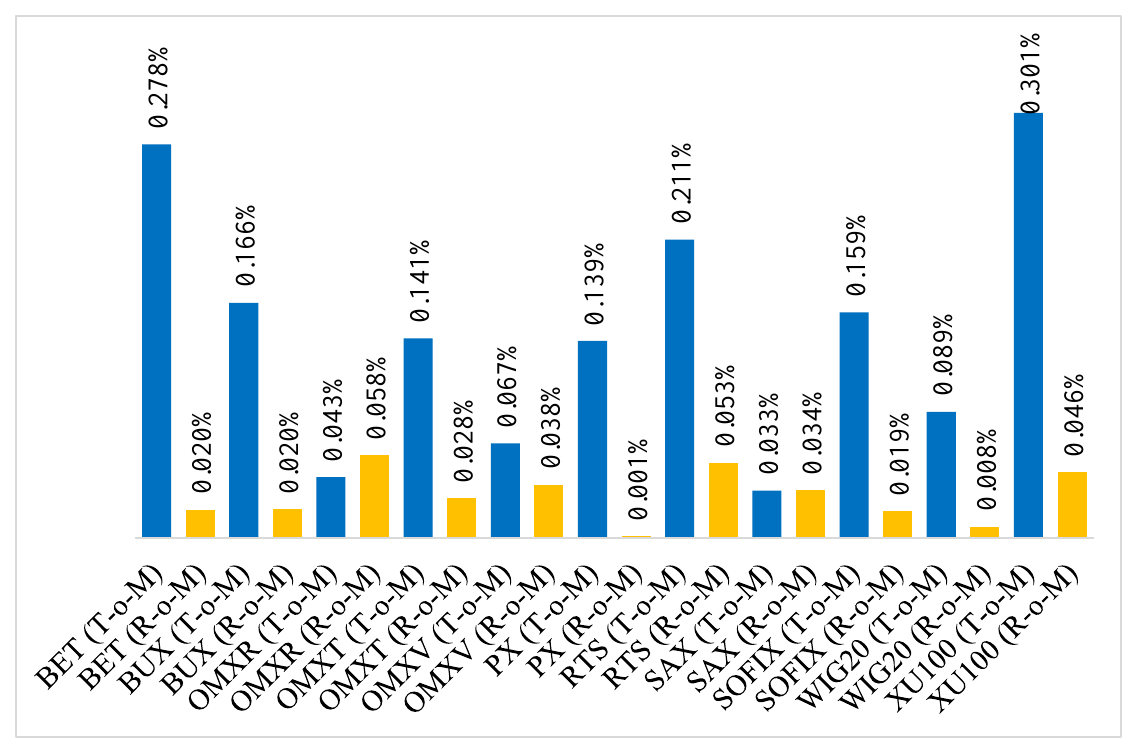
Figure 2. Comparison of average daily returns—Turn of the month window (2+2). Table 3. Results of the statistical significance tests—Turn of the month window (2+2).